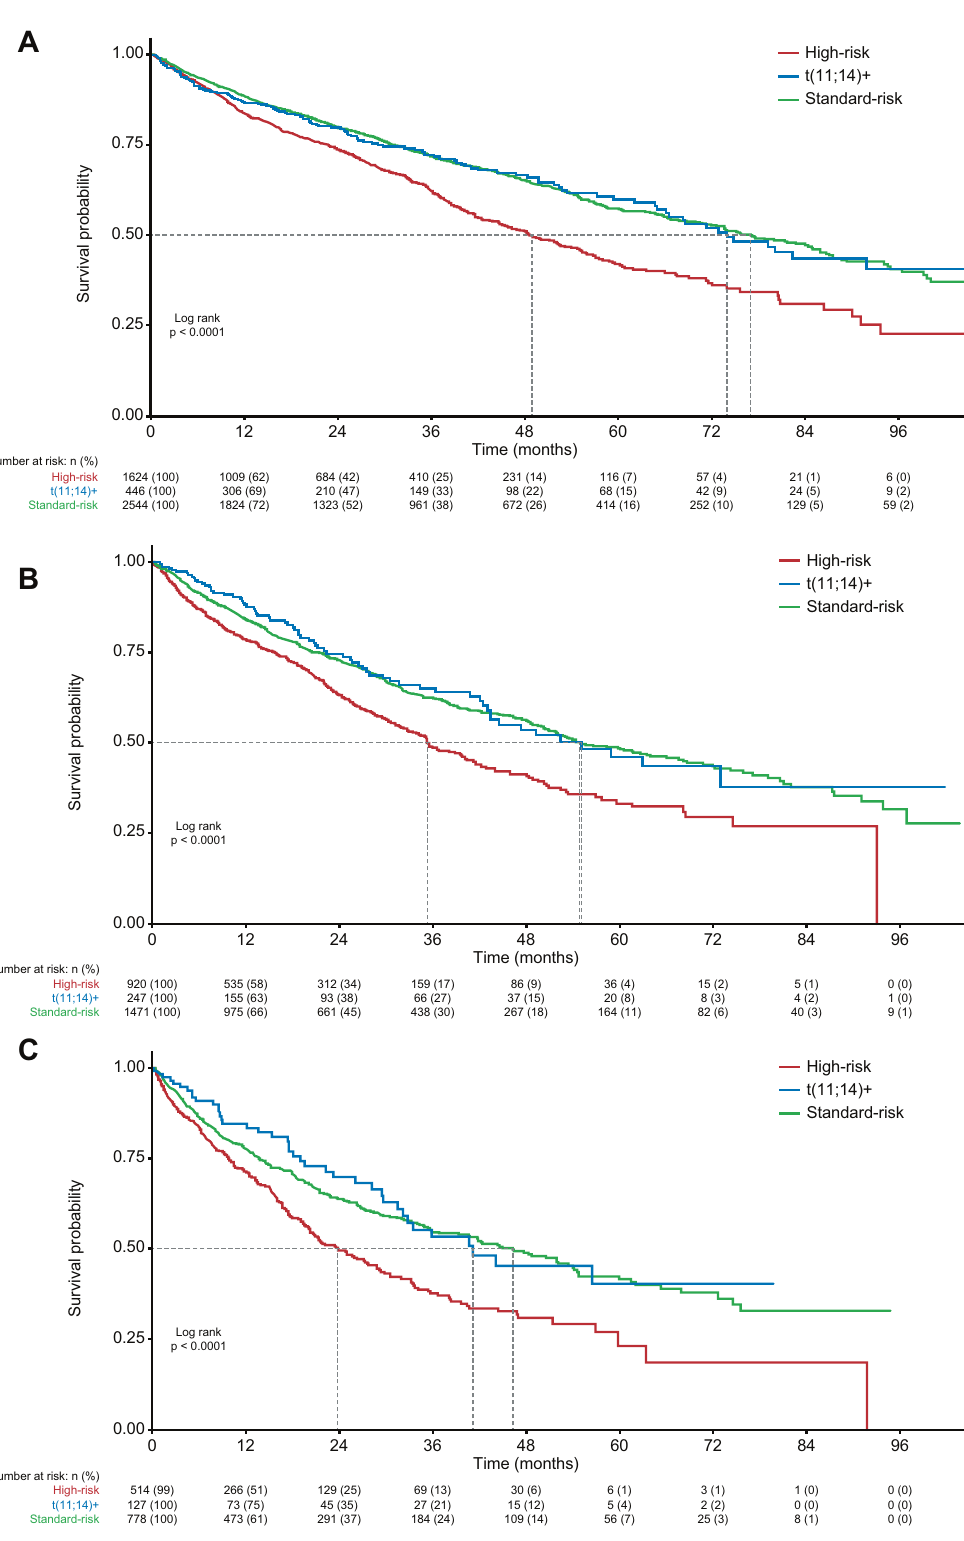
Fig. 4 Kaplan – Meier curves for OS by patient risk subgroup. First-line ( A ), second-line ( B ), and third-line ( C ) treatment. OS overall survival, t